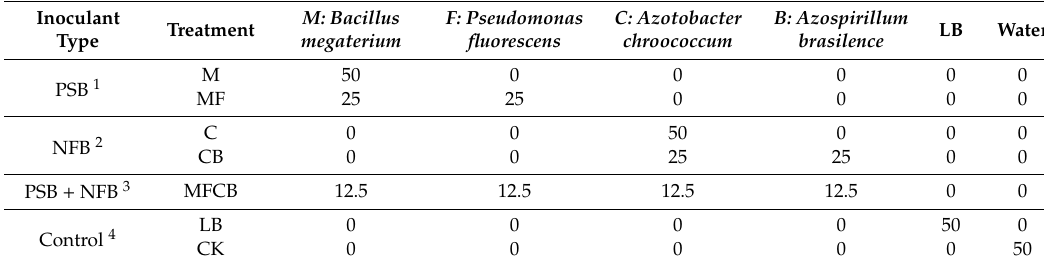
Table 1. Fertilizing doses of seven bio-fertilization regimes (mL · pot − 1